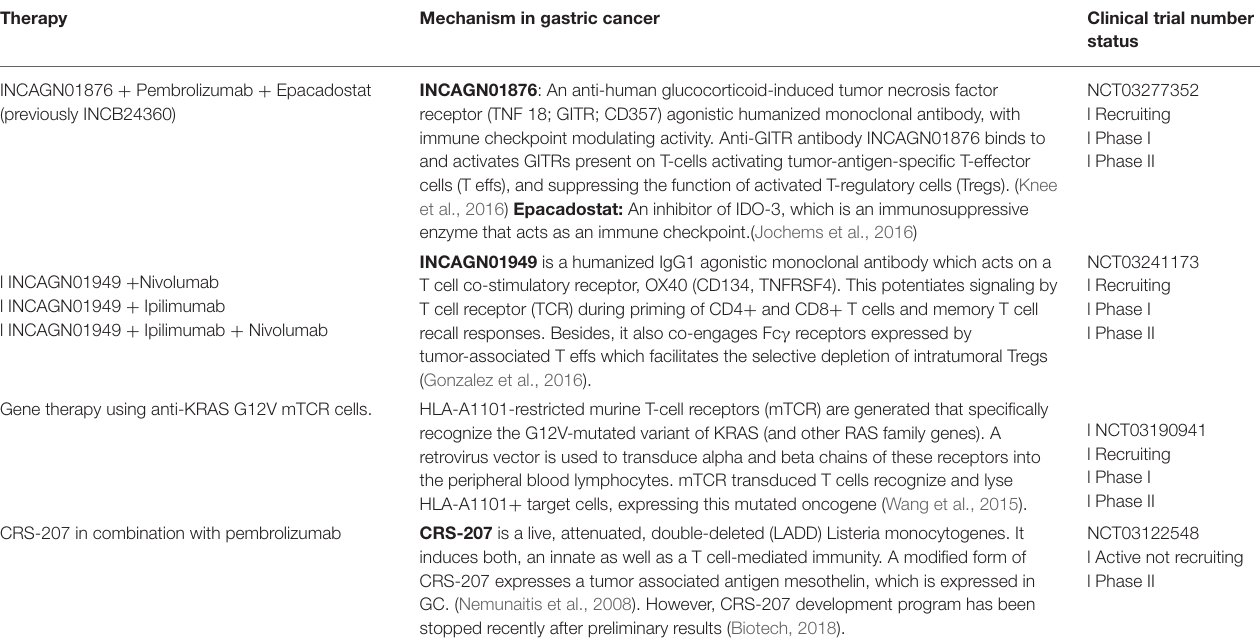
TABLE 3 | Other promising immunotherapies in patients with advanced stage gastric carcinoma.